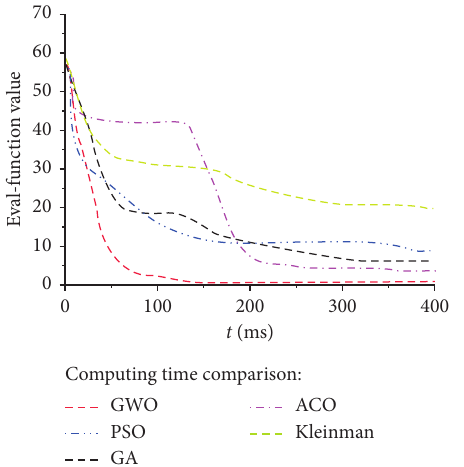
Figure 8: Comparative trends and performances of optimization algorithms.